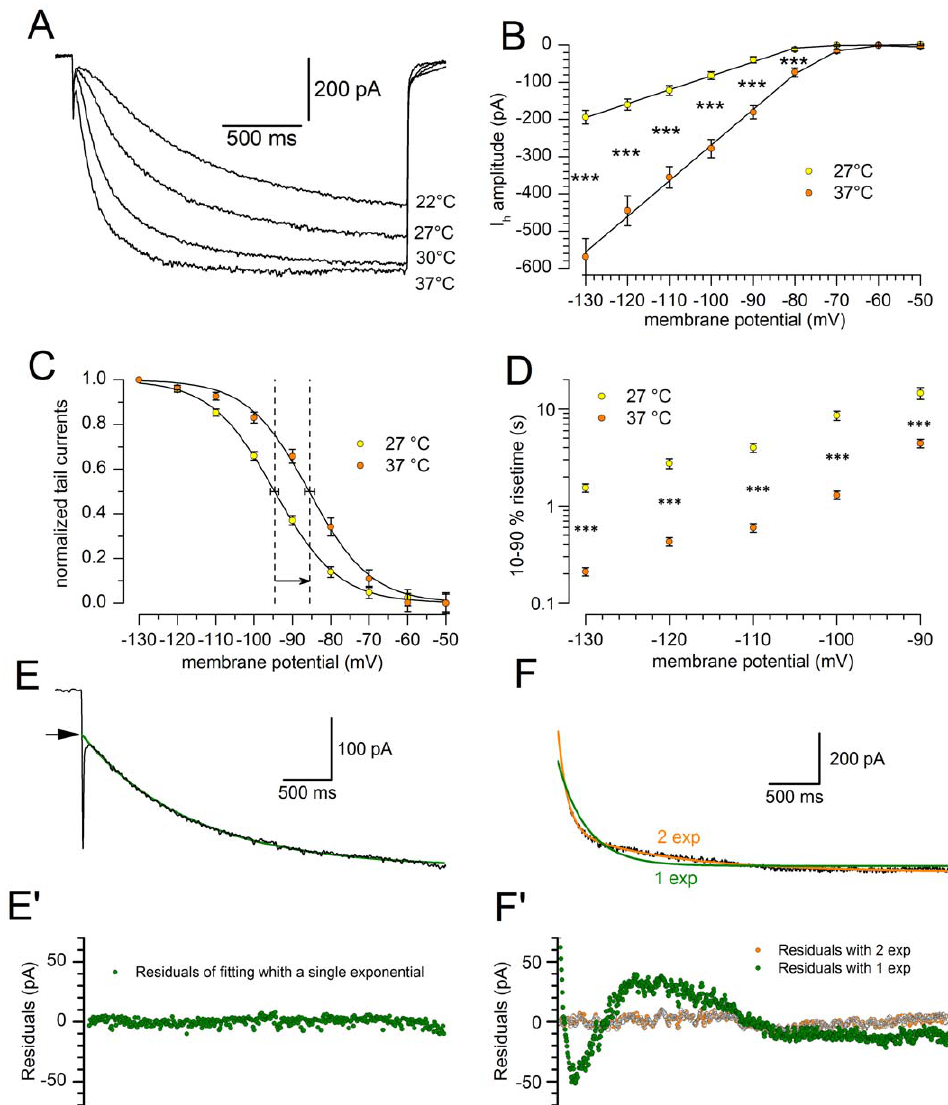
Figure 4. Effect of temperature on h-current amplitude and kinetics. A: Family of current tracings recorded in a single cell in response to hyperpolarizing pulses from 2 40 to 2 130 mV, repeated at the temperatures indicated. B: Comparison of the I/V curves recorded at 27 (yellow dots) and 37 u C (orange dots); n=20; the difference, tested with two-way ANOVA and post-hoc Bonferroni test, is significant at 0.001 level for the potentials more negative than 2 70 mV. C: Shift of the steady-state activation curves for a change from 27 u C (yellow) to 37 u C (orange), average values from 13 cells 6 S.E for the V 50 . D: Effect of the temperature on the h-current 10–90% risetime at 27 u C (yellow) and 37 u C (orange); see explanation in the text. E, E 9 : Sample fit with a single exponential of an h-current tracing obtained at 27 u C in response to a voltage step to 2 130 mV; below the analysis of the residuals (experimental data minus the corresponding values of the fitting curve). F, F 9 : Sample fit with both single (green) and double (orange) exponential of a h-current tracing obtained at 37 u C in response to a voltage step to 2 130 mV; below the analysis of the residuals in the same grey scale code. All the recordings shown in this figure were obtained in perforated patch conditions. doi:10.1371/journal.pone.0052329.g004 cAMP; at any tested potentials the increase in current amplitude was statistically significant (P , 0.005 level, t-test for paired data). (Figure 7A, yellow dots). However, when the bathing solution was further enriched with 0.1 mM IBMX, a phosphodiesterase The effect of forskolin on the h-current is twofold. First, it inhibitor [49], the depolarization induced by forskolin was more promotes a depolarizing shifts of the steady-state activation curve prominent (7.9 6 1.8 mV, n= 5), and persisted as long as the V 50 in the depolarizing direction of 6.33 6 0.78 mV (n= 8; a application of the drug was maintained (Figure 7A, orange dots). variation significant at 0.0005 level; Figure 7C). In addition, following the increase of intracellular levels of cAMP, the I h Under voltage-clamp conditions, the bath application of 10 m M activation time course becomes significantly faster: from forskolin and 0.1 mM IBMX, induce a significant increase of I h 1763 6 340 ms in control to 1435 6 298 ms for the 10–90% rise amplitude (Figure 7B): at 2 130 mV the current amplitude is 2 178.5 6 23.5 pA in control conditions (n= 8), and time (n= 8; p , 0.025) at 2 100 mV (Figure 7D). 2 227.0 6 34.2 pA (n= 8) in the presence of increased levels of